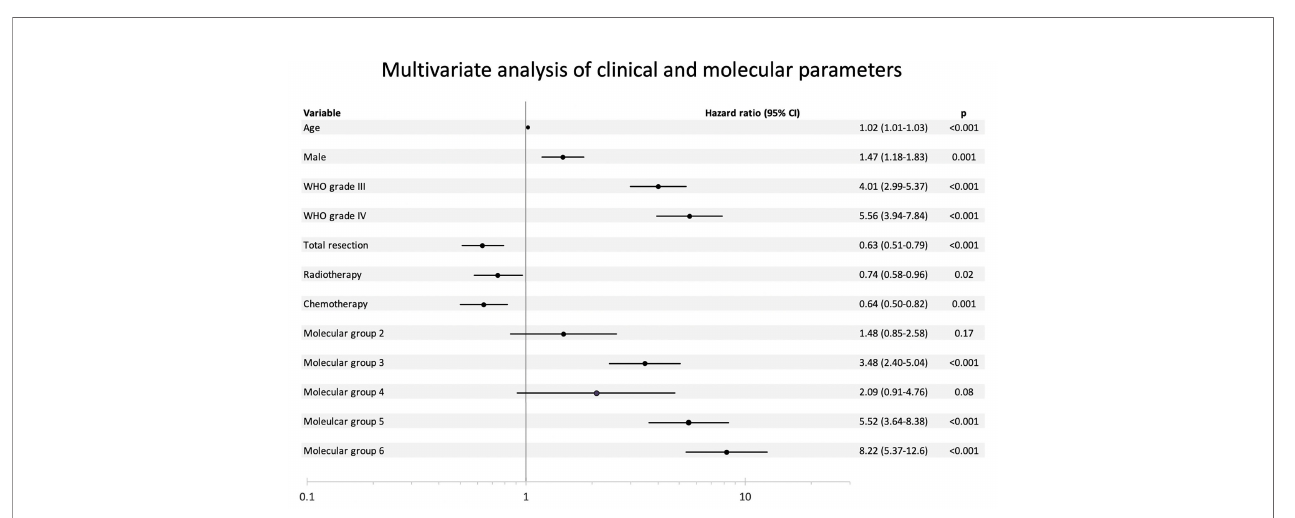
FIGURE 2 | Multivariate analysis of clinical and molecular